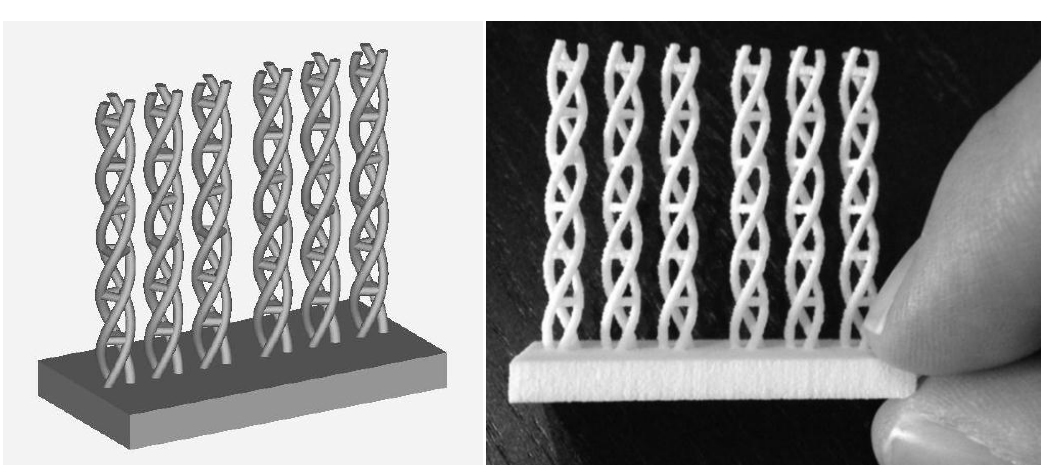
Figure 2. Selected computer-aided design of frameworks for knitting the carbon fibers and rapid prototype obtained by selective laser sintering of polyamide powder. For the math-based CAD processing of these helical biomimetic structures for fibrillar tissue repair, see previous work by our team [4].